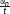
An illustration of a hypothetical mouse trajectory in a no-go trial. This hypothetical trial had ended before participant had made a response (i.e., clicking the button). Total distance (measured by pixels) of a mouse movement is calculated as a sum of all distances from the starting position to the end position that are recorded at each time slice (α1, α2 … αn). If 2400 ms pass before the participant makes a response, all trajectories recorded during the trial are added. No movement is treated as movement with distance equal to zero. Velocity is calculated as a length of distance between two sets of coordinates divided by the time elapsed between their recordings (, t - constant). A maximum velocity is selected for each trial. Acceleration is calculated as an increase in velocity between two recordings, and then a maximum value for each trial is selected.